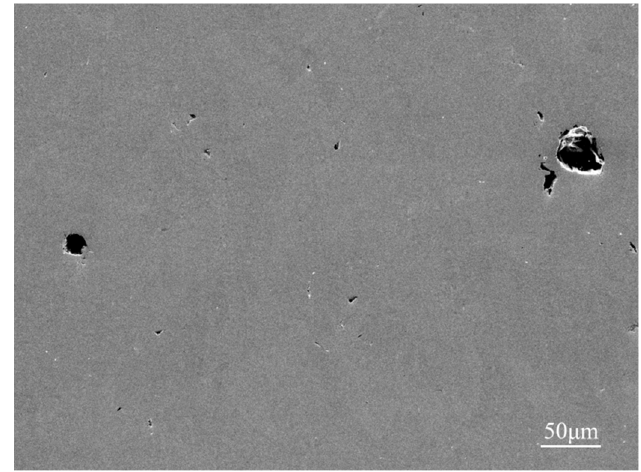
Figure 5. SEM image of the gas porosities with spherical shape in HEAs.